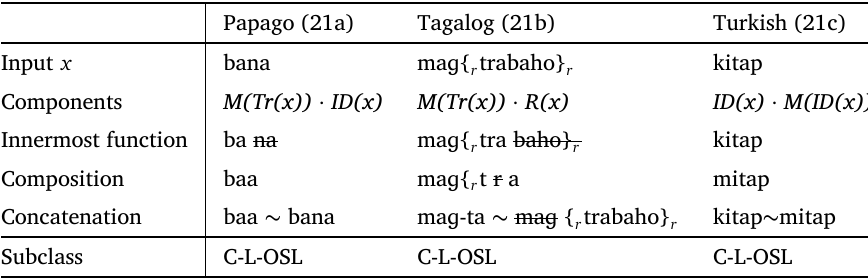
Table 9: C-OSL treatment for phonological changes to the reduplicant Papago